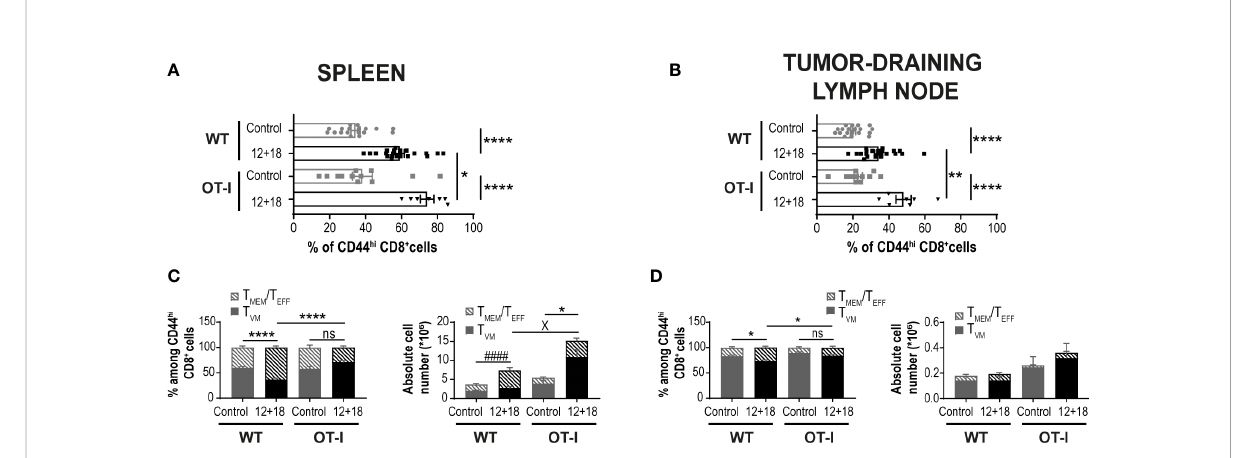
FIGURE 5 Effects of systemic co-expression of IL-12 plus IL-18 on CD8 + T lymphocytes in SLO from WT and OT-I mice. OVA neg B16-bearing C57BL/6 WT and OT-I mice were hydrodynamically injected (HI) with IL-12 plus IL-18 cDNA (12 + 18) or empty cDNA as the control. After 7 days post-HI mice were euthanized, and spleen and dLN were harvested and processed for fl ow cytometry. (A, B) Bar graphs represent frequencies of CD44 hi CD8 + T cells on (A) spleen or (B) dLN from control or 12 + 18 WT or OT-I mice. (C, D) Bar graphs show frequencies and absolute cell numbers of T MEM /T EFF and T VM cells among CD44 hi CD8 + T cells from (C) spleen or (D) dLN from control or 12 + 18 WT or OT-I mice. Statistical analysis was performed with One-way ANOVA (A-D) . Values of *p<0.05, **p<0.01, ****p<0.0001 were consider signi fi cant. #### p<0.0001 represents the statistical difference of the indicated T MEM /T EFF control vs 12 + 18 subpopulations, while X p<0.01 represents the difference among the speci fi ed control and 12 + 18 T VM cells, * indicates an statistical difference in both subpopulations of memory CD8 + T